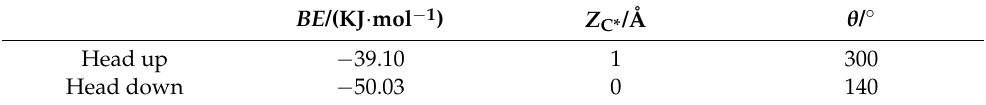
Table 4. Binding energies for SA/ β -CD calculated by ONIOM (B3LYP/6-31G: PM3) method.